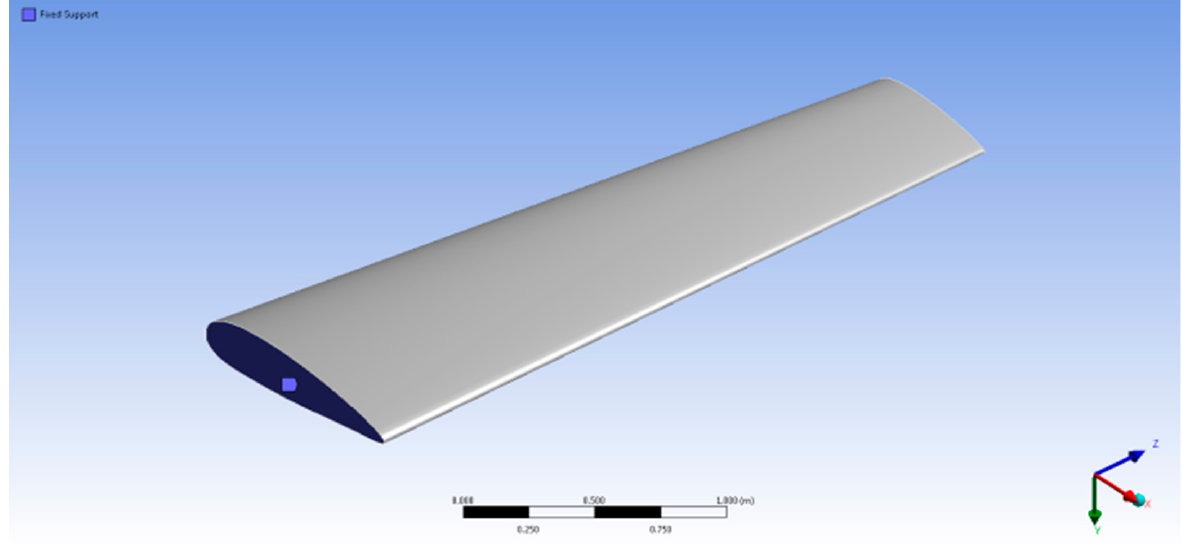
( b ) Figure 10. Initial naming conditions of an airplane wing, CFD Analysis. ( a ) A systematic representation of imposed naming on entire CFD domain. ( b ) A systematic projection of imposed naming on airplane wing–zoomed view.